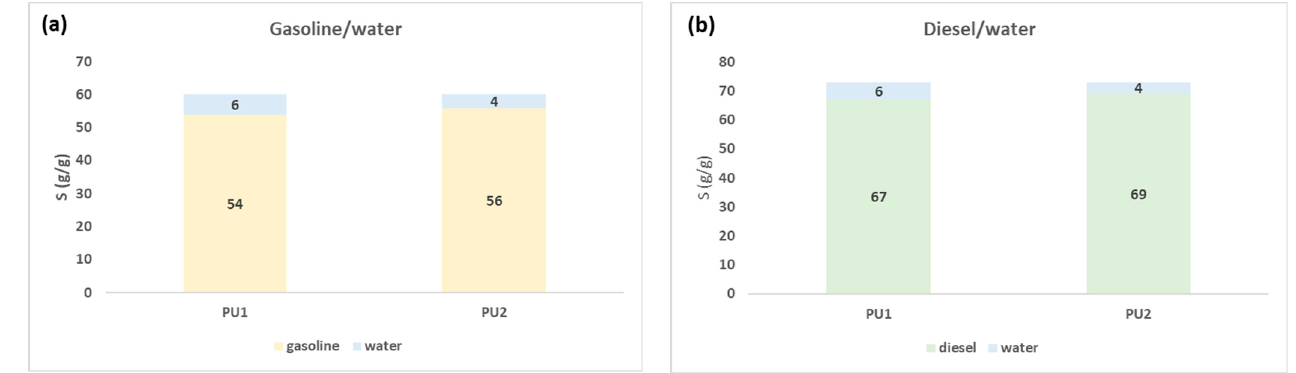
Figure 6. Total sorption capacity of PU1 and PU2 in gasoline/water ( a ) and diesel/water ( b ) systems starting from a solution of 80 g/L in continuous fl ow.